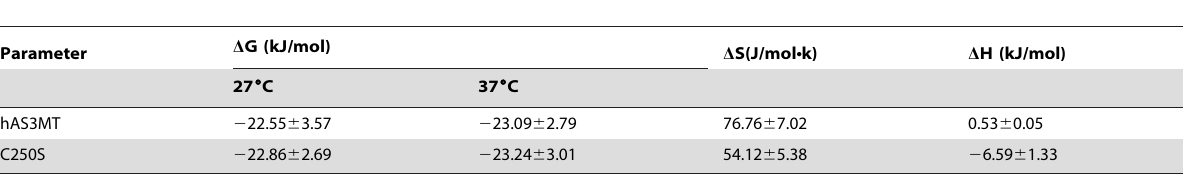
Table 6. Thermodynamic parameters for the binding of AdoMet to hAS3MT/C250S.